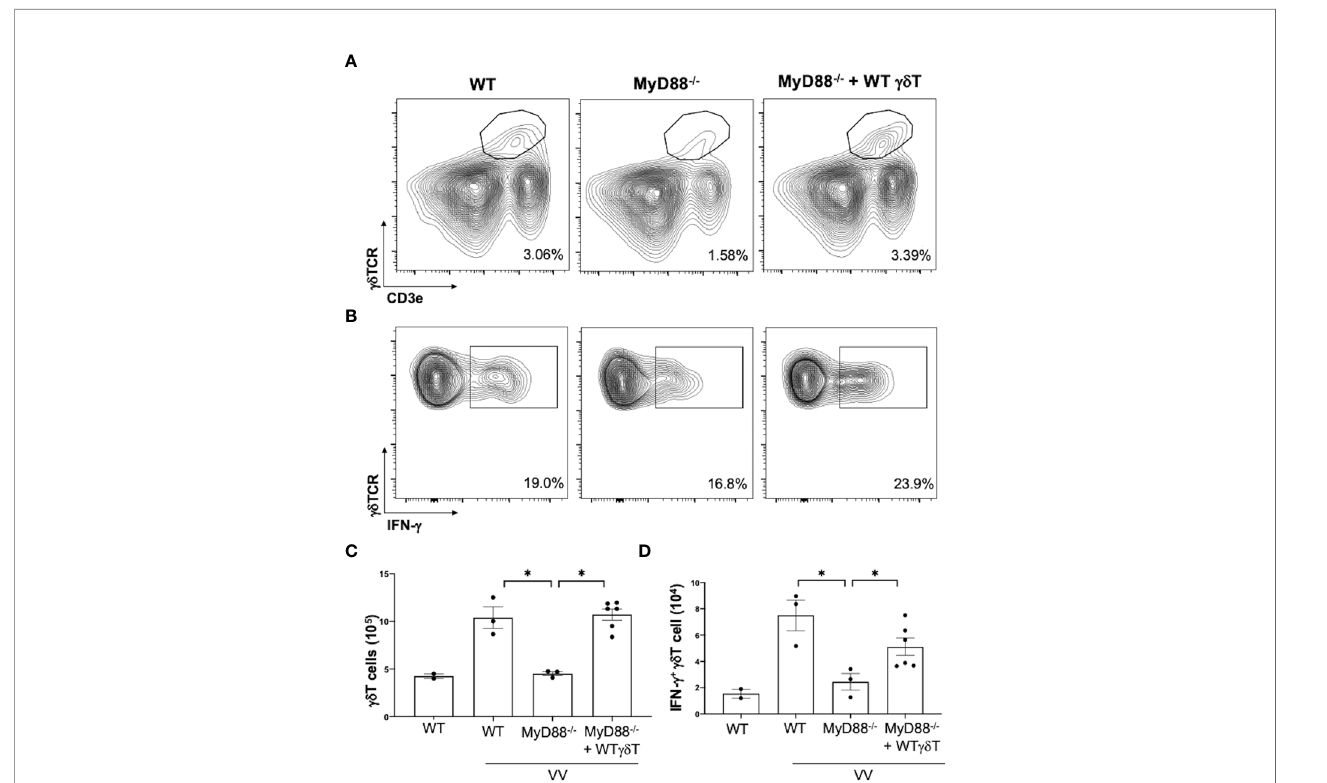
FIGURE 6 | Intrinsic MyD88 signaling is required for activation of gd T cells by VV. 5 x 10 6 pfu of VV was inoculated into WT and MyD88 -/- mice with and without adoptive transfer of 1 x 10 6 cells of WT gd T cells. Mice splenocytes were harvested 4 days after inoculation and assessed via fl ow cytometry. (A) Representative FACS plots of live cells plotted for CD3e + gd TCR + splenocytes, 4 days after VV inoculation. (B) Representative FACS plots fi rst gated on CD3e + gd TCR + splenocytes, and then assessed for IFN- g positivity. The gating for IFN- g is determined against gd T cells from control naïve mice for each experiment. (C) Summary graph of a representative experiment for positive CD3e + gd TCR + T cells in mice, 4 days post-VV inoculation. (D) Summary graph of a representative experiment for IFN- g + CD3e + gd TCR + T cells in mice, 4 days post-VV inoculation. Representative of 3 independent experiments. ANOVA with post-hoc t-test, * P <